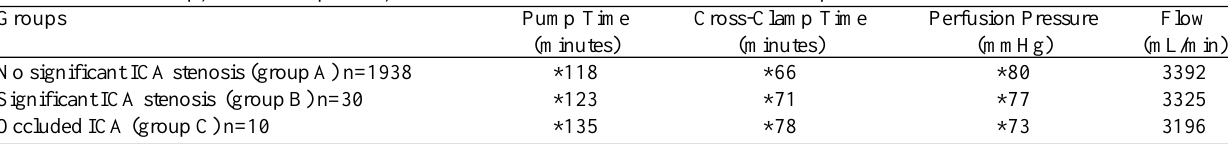
Table 2. Mean Pump, Cross-Clamp Time, Perfusion Pressure and Flow in Different Groups. Groups